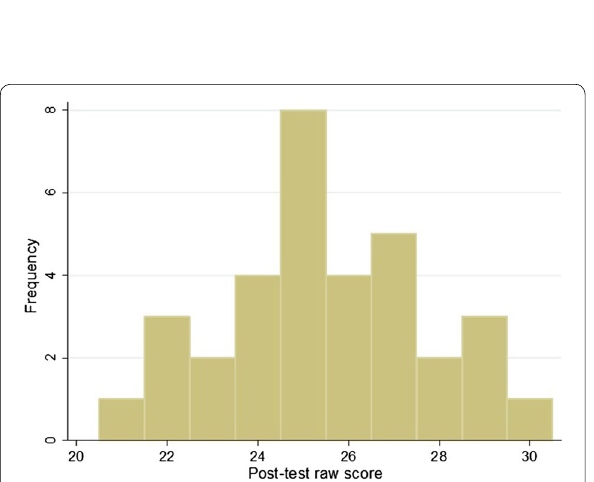
Fig. 3 Distribution of immediate post-test raw scores (of a possible 30 points), n 33 =